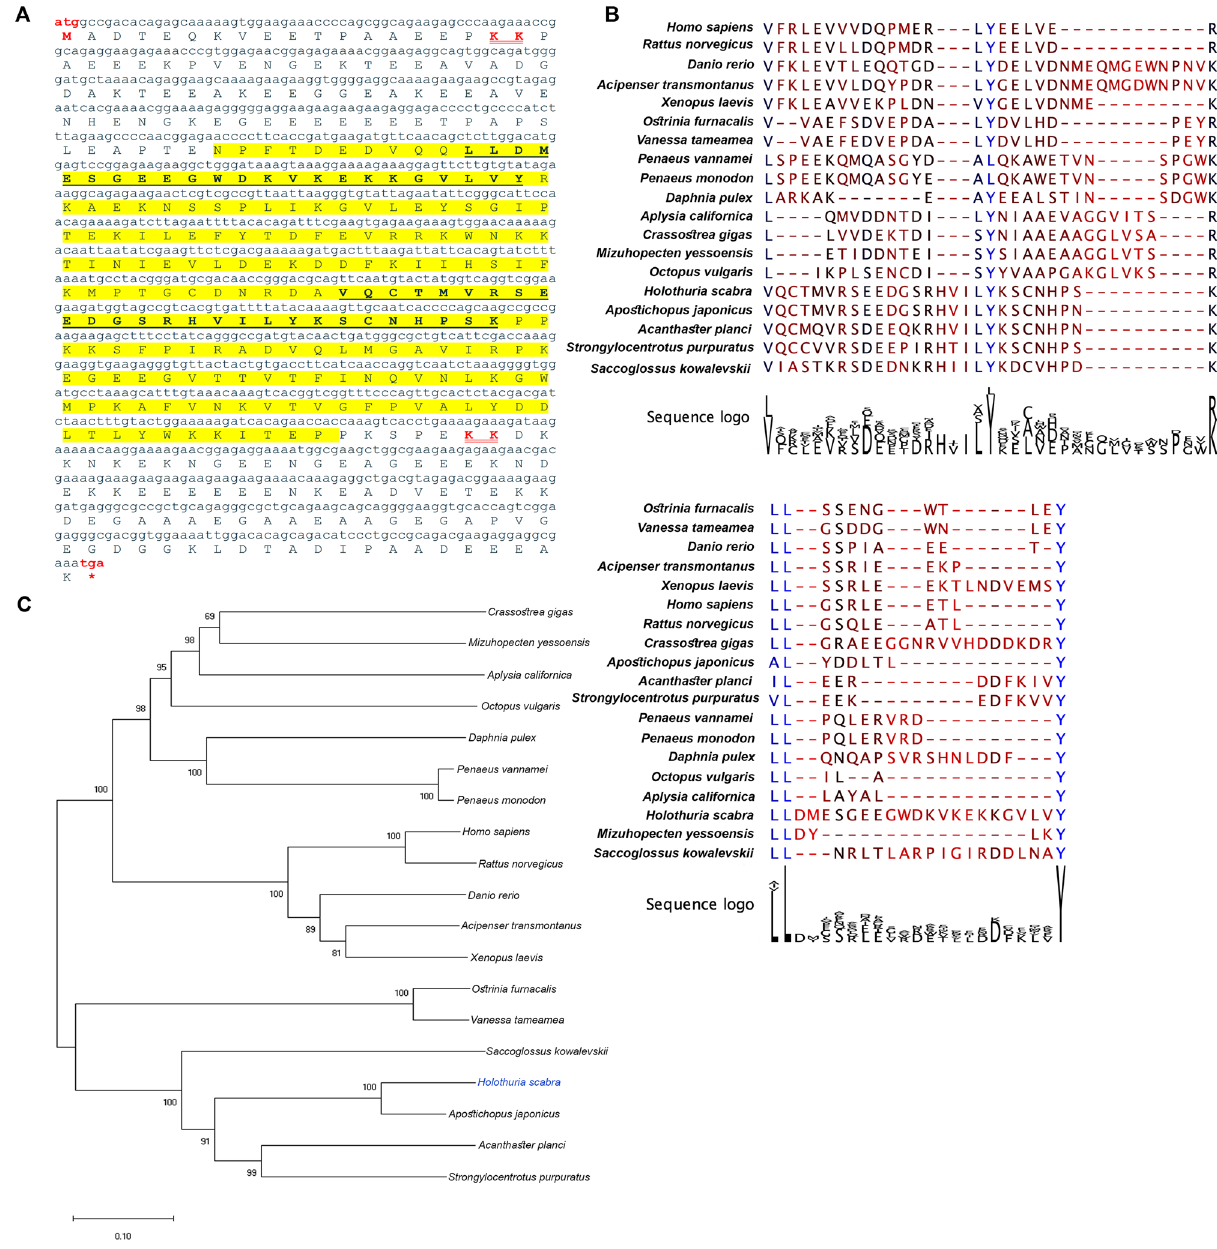
Figure 3. Characterization and phylogenetic tree analysis of H. scabra steroidogenic acute regulatory protein (StAR). ( A ) HscStAR contains the steroidogenic acute regulatory protein-related lipid transfer domain (START domain) (yellow highlight) which consists of cholesterol recognition/interaction amino acid consensus (CRAC) (L/V-(x)-Y-(x)-R/K) and dileucine- and tyrosine- (LL-(x)-Y) motifs (bold underlined letters), cleavage site (red double-underlined letters), start and stop codons (red letters). ( B ) Multiple sequence alignment of CRAC and LL-(x)-Y key motifs of StAR displays conservation among species. Sequence alignment represented by * = identical, : = strong homology, and . = less homology. ( C ) Phylogenetic tree of HscStAR constructed based on Neighbour-joining analysis with 1000 replicates bootstrap. Scale bar represents amino acid differences. Amino acid sequences and their accession number are shown in